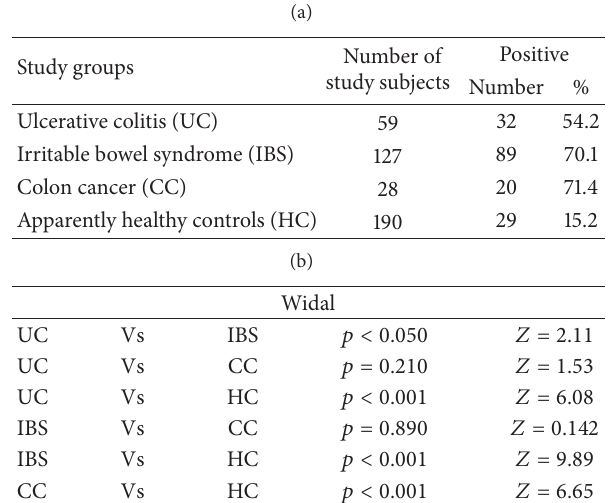
Table 3: Positivity for antibody in the study population against S